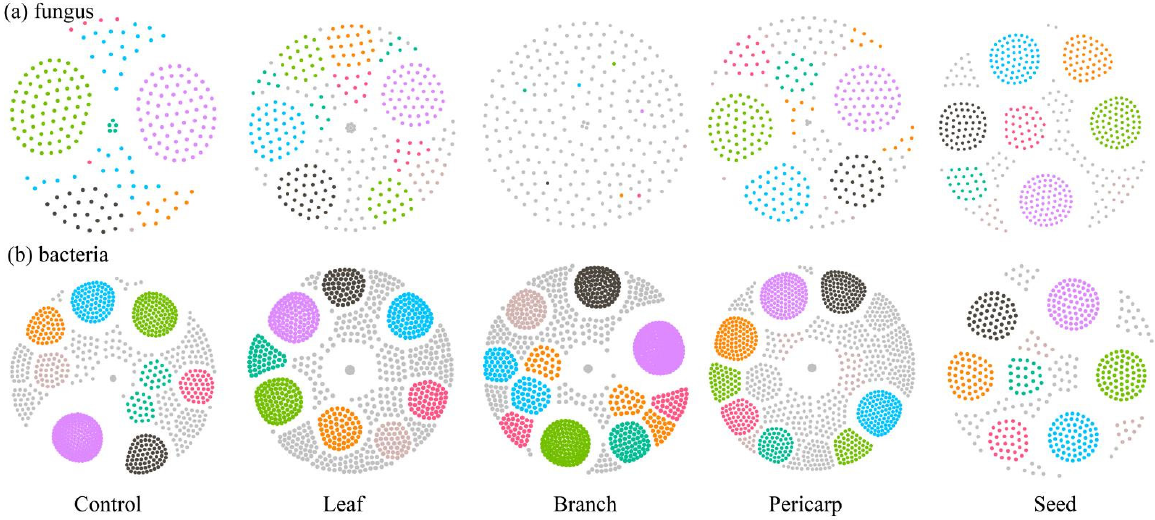
Figure 8. Microbial community ecological networks displayed at the operational taxonomic unit (OTU) level in topsoils in the different treatments (control, leaf, branch, pericarp, and seed). ( a ) Fungus ecological networks (OTU level), ( b ) bacteria ecological networks (OTU level).